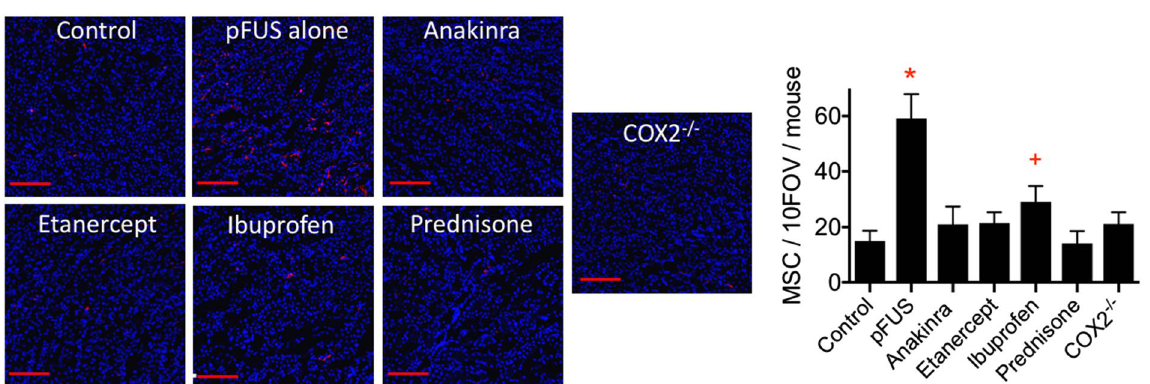
Figure 5. Renal tropism of MSC is suppressed by anti-inflammatory drugs and in COX2-KO mice. MSC do not routinely home to control kidneys (no pFUS, no drugs). Homing is enhanced ~5 fold in the pFUS-treated group (pFUS, no drugs). When anti-inflammatory drugs are administered prior to pFUS or pFUS is administered to COX2-KO mice without drug pretreatments, MSC tropism is suppressed compared to the pFUS alone group (p < 0.05). MSC homing to pFUS-treated kidneys of mice given ibuprofen was significantly greater than control kidneys (p < 0.05) but also significantly less than kidneys treated with pFUS alone. (n = 6 mice per treatment group; multiple comparisons made by ANOVA with Bonferroni post-hoc tests; symbols indicate statistically significant differences from groups with different or no symbol; Scale bars = 100 μ